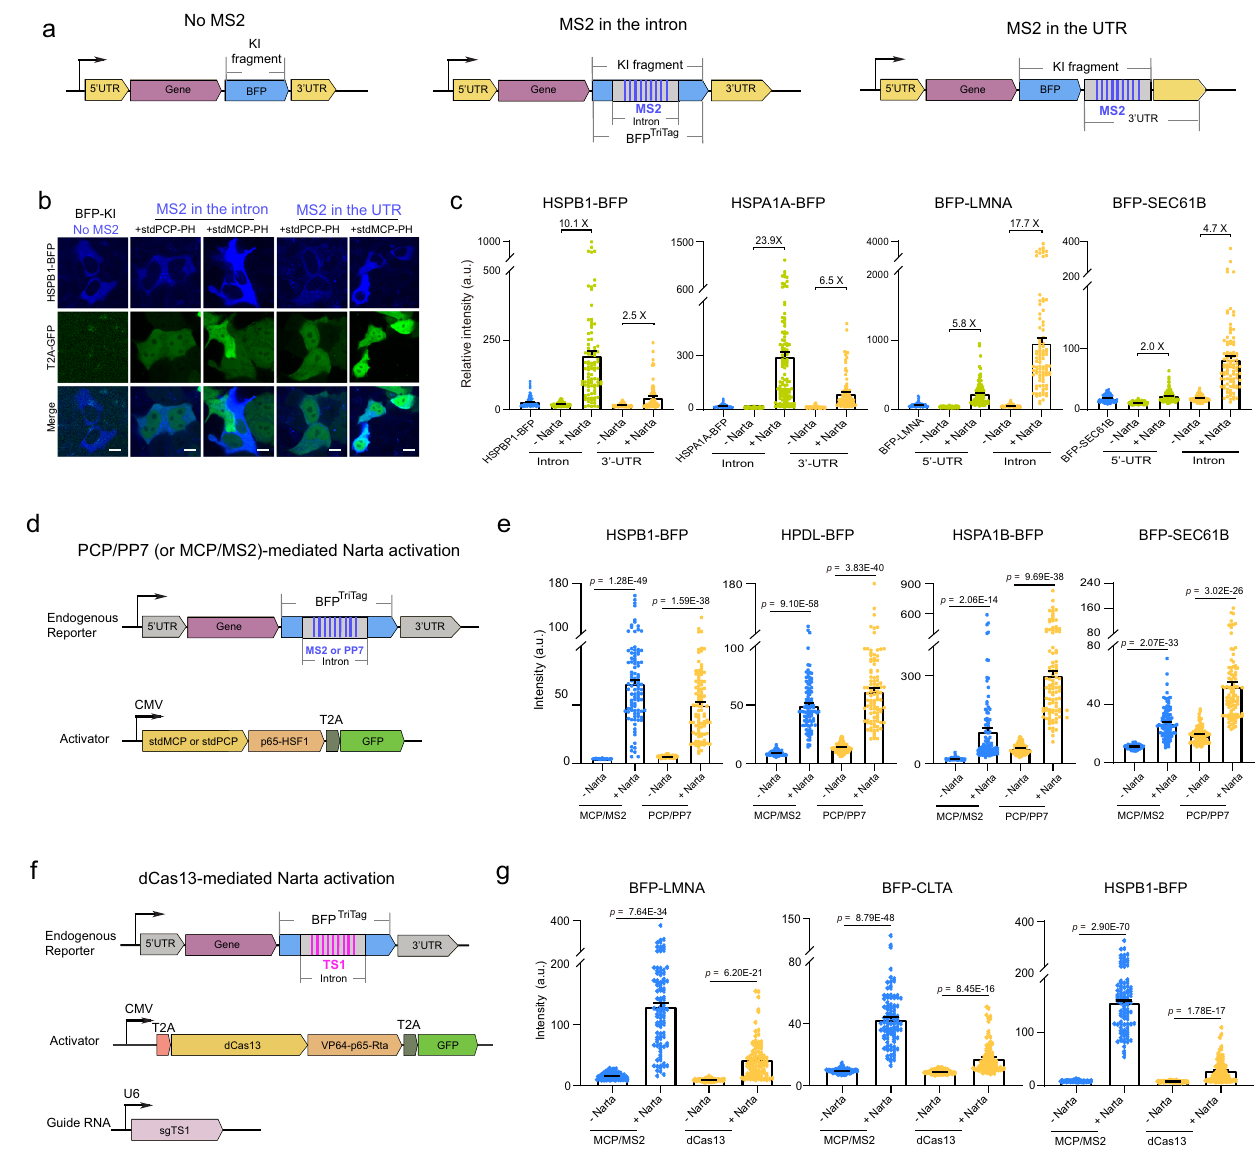
Fig. 2 | Factors that contribute to Narta ef fi ciency. a Schematic diagram of dif- ferent knockin fragments and two different MS2 positions (in the intron or UTR region). b Representative images to show HSPB1 expression under various condi- tions, including different BFP tagging strategies illustrated in a . Scale bar, 10 μ m. c Quanti fi cations of protein expression based on fl uorescent imaging under dif- ferent conditions as shown in a . Each dot represents a single cell. n =90 cells. d Schematic of the components to mediate Narta activation by PCP/PP7 or MCP/